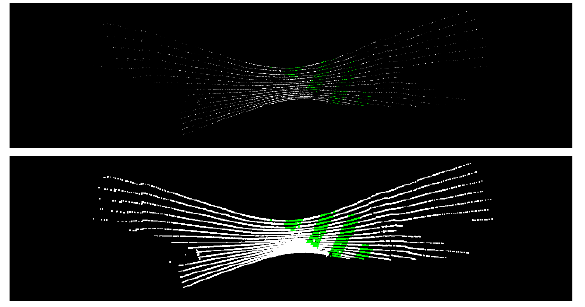
Figure 5. (Top) Original and (Bottom) Dilated Images